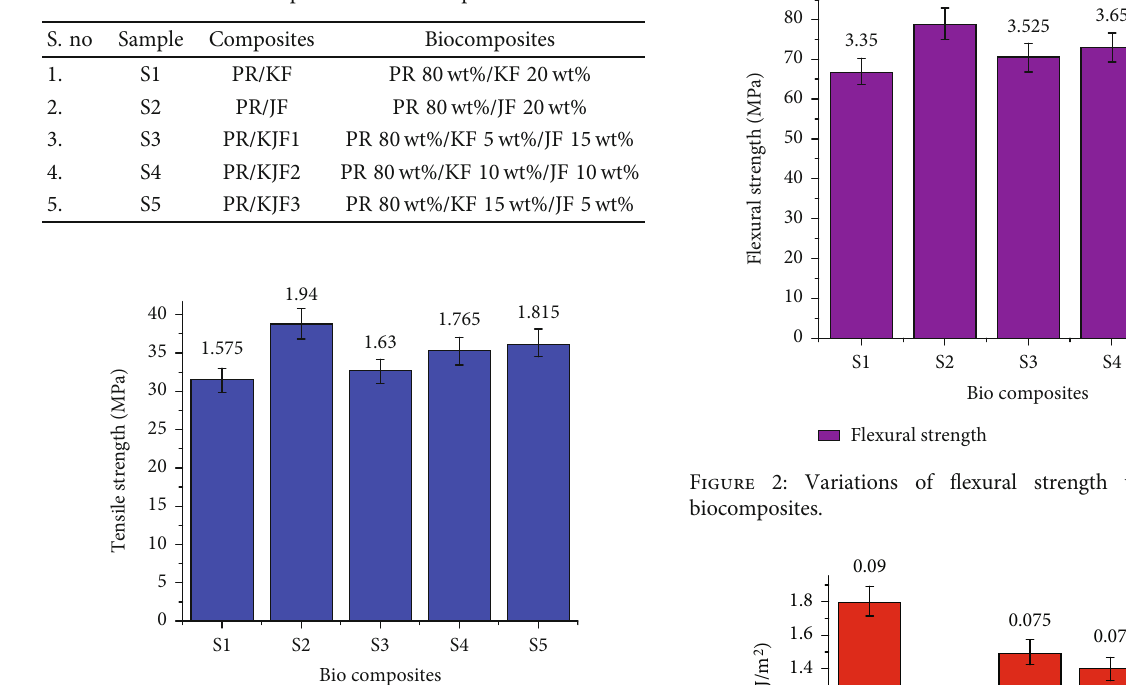
Table 1: Composition of biocomposites.